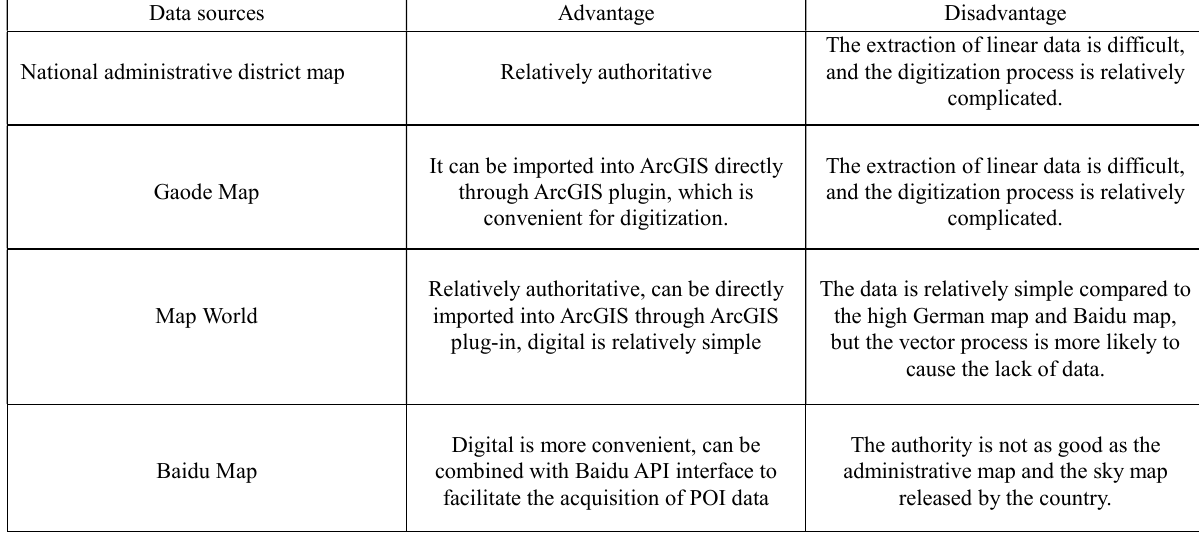
Table 1. Comparison of various types of map